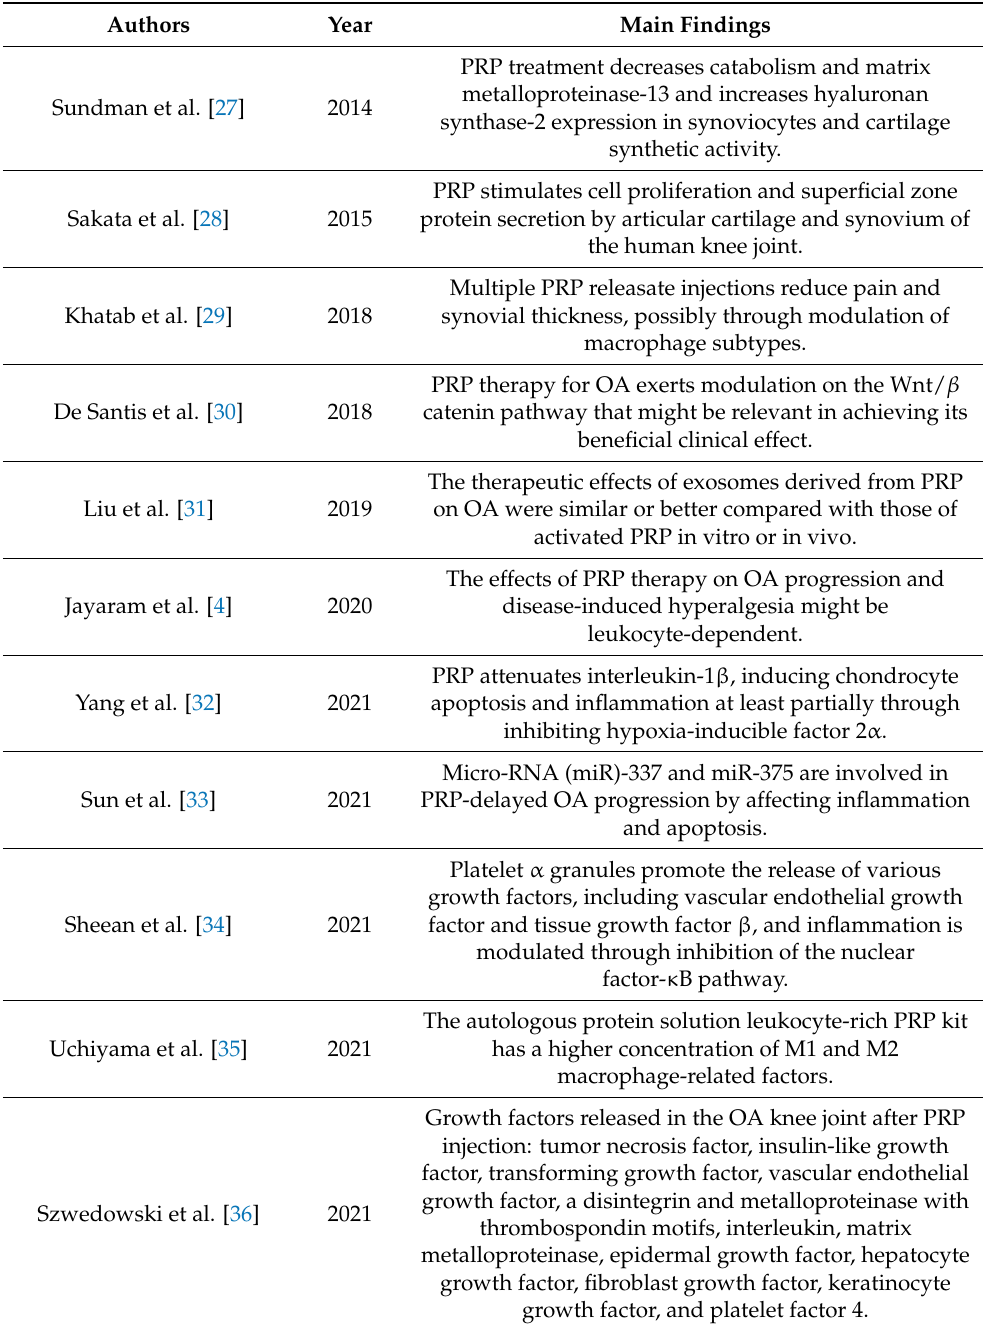
Table 1. Summary of PRP’s molecular mechanisms of